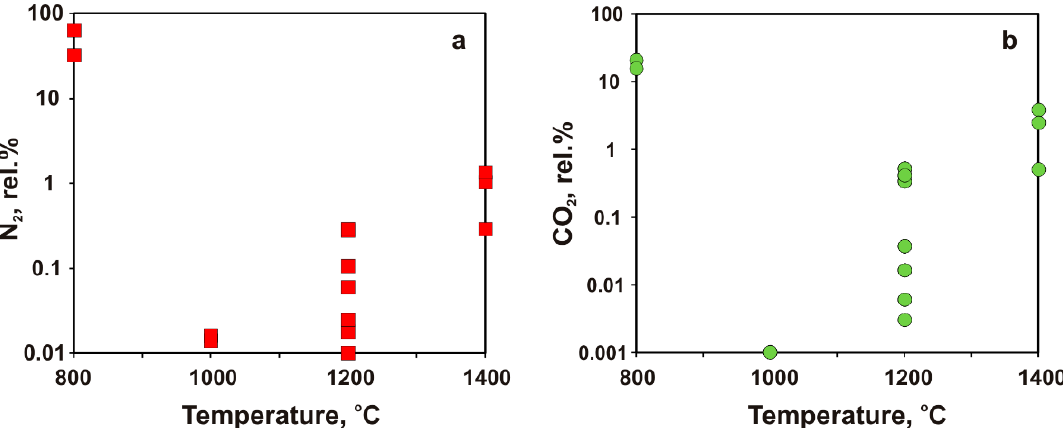
Figure 2. Concentrations of ( a ) N 2 and ( b ) CO 2 in quenched fluids obtained in 800–1400 ° С runs.